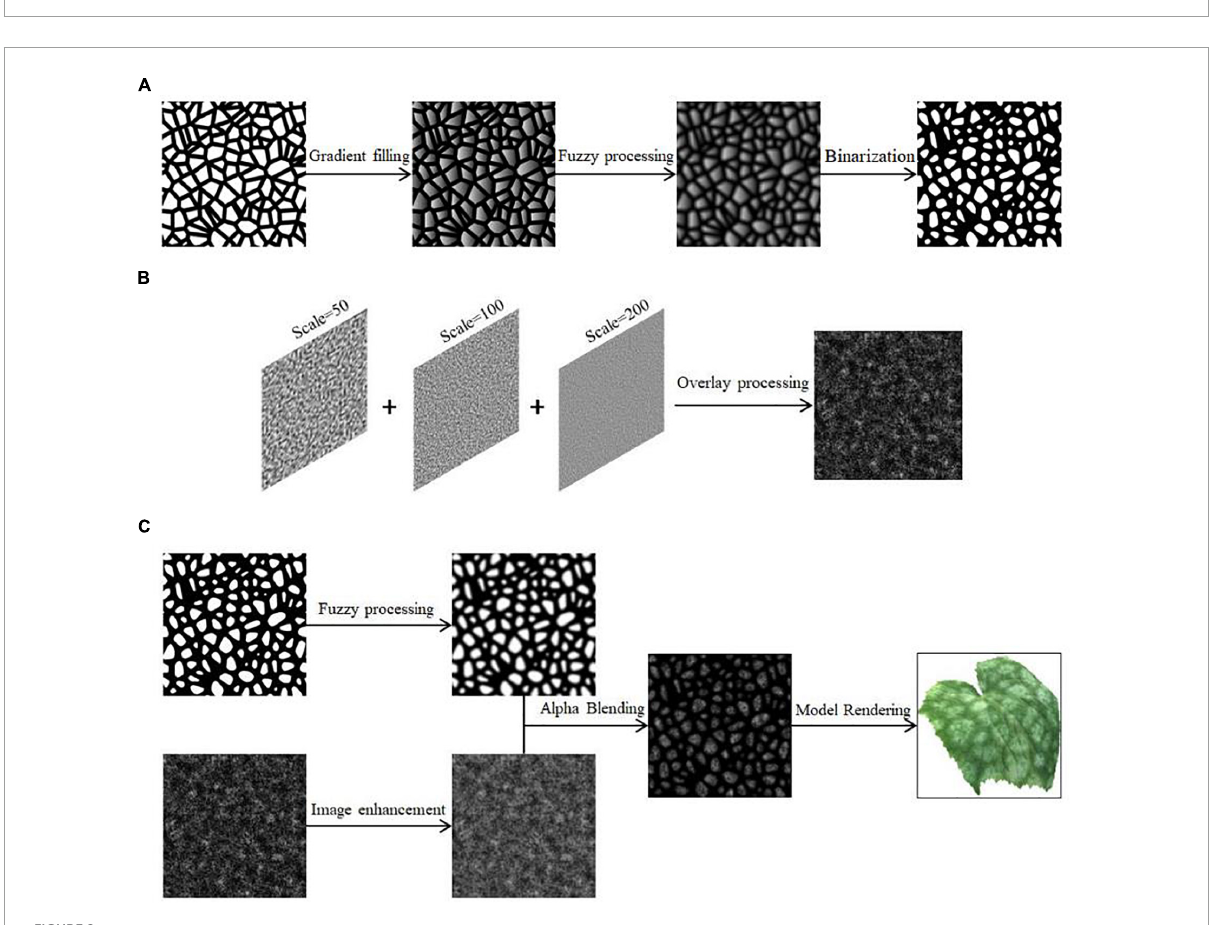
FIGURE2 Schematic diagram of cucumber powdery mildew simulation. (A) Transformation of Worley noise, (B) Perlin noise superimposition, (C) generation of powdery mildew spot texture.